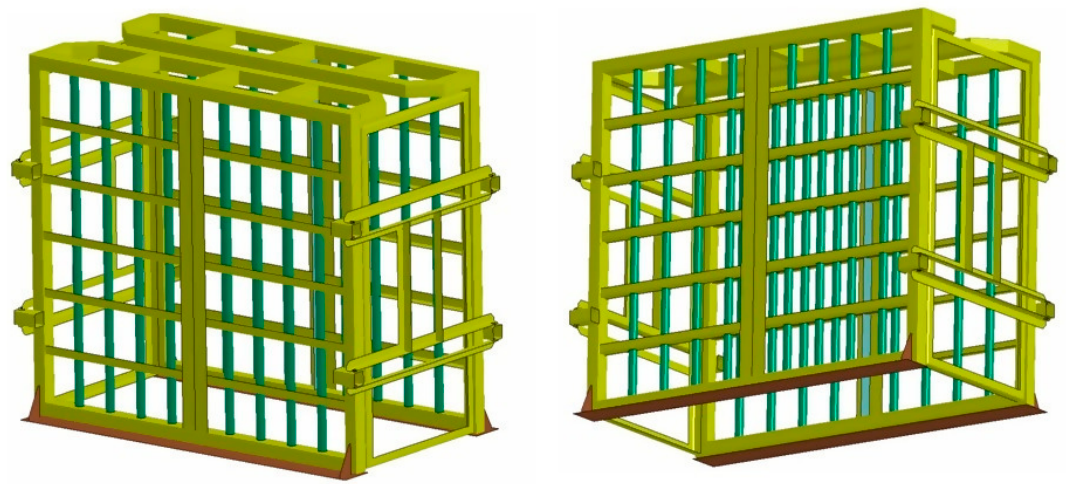
Figure 6. Overview of the geometric model of the safety cage used for loose tire inflation.